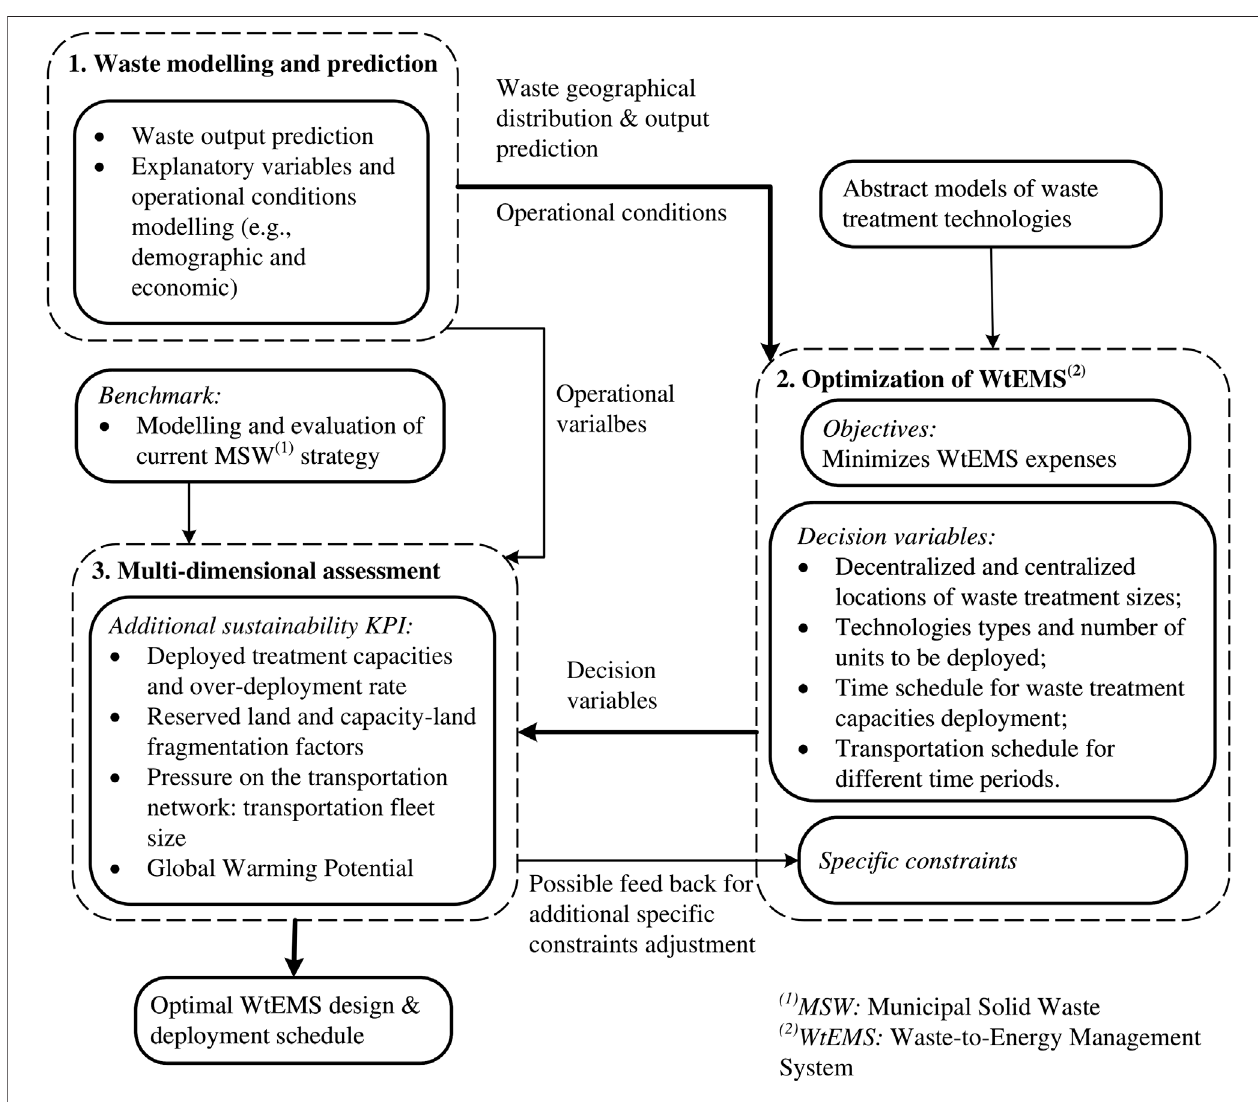
FIGURE 1 | Integrated decision support method for WtEMS design: methodology fl owchart.